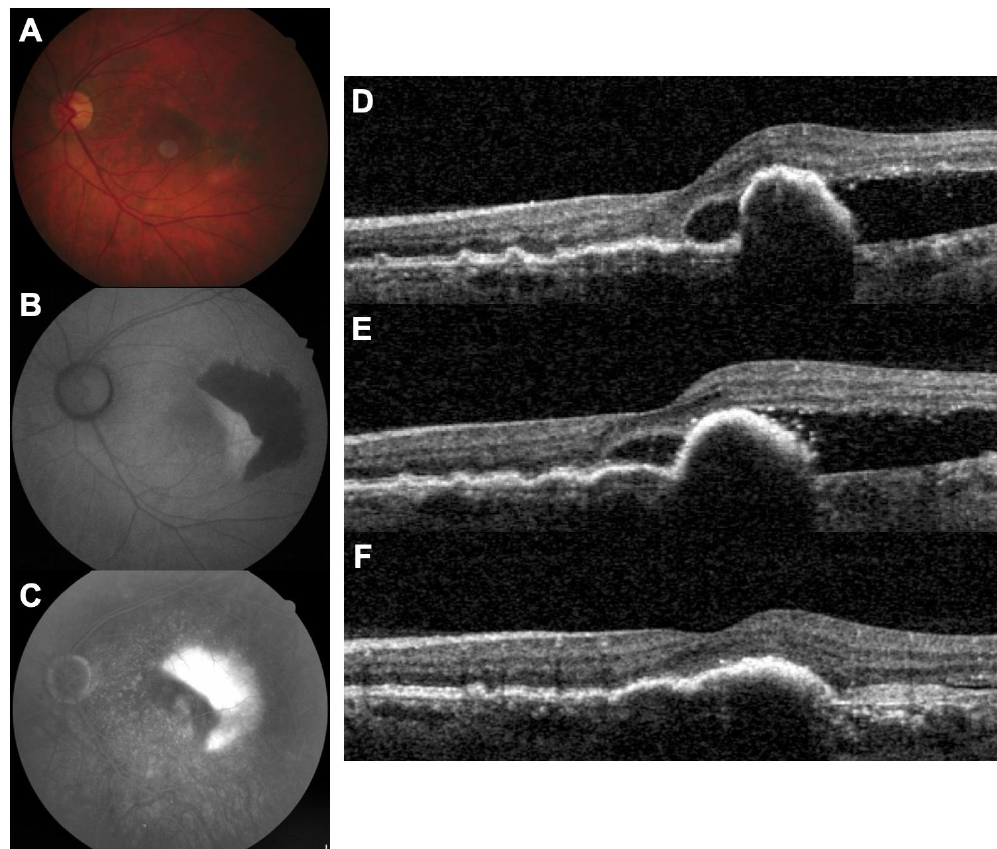
Figure 1. RPE tear complicating a type 1 CNV of a 74-year-old man (case 1). ( A ). Fundus photography showing RPE hyperpigmentation in the foveal area; ( B ). fundus autofluorescence demonstrating a large area of hypoautofluorescence in the temporal macula; ( C ). fluorescein angiography showing a window effect in front of the RPE tear; ( D ). baseline OCT showing a double layer sign under the fovea and a large PED with an absence of RPE in the temporal macula (i.e., RPE tear). SRF is present. ( E ). OCT after 4 monthly intravitreal injections of aflibercept, showing persistent SRF; ( F ). OCT after 2 intravitreal injections of brolucizumab showing a favorable